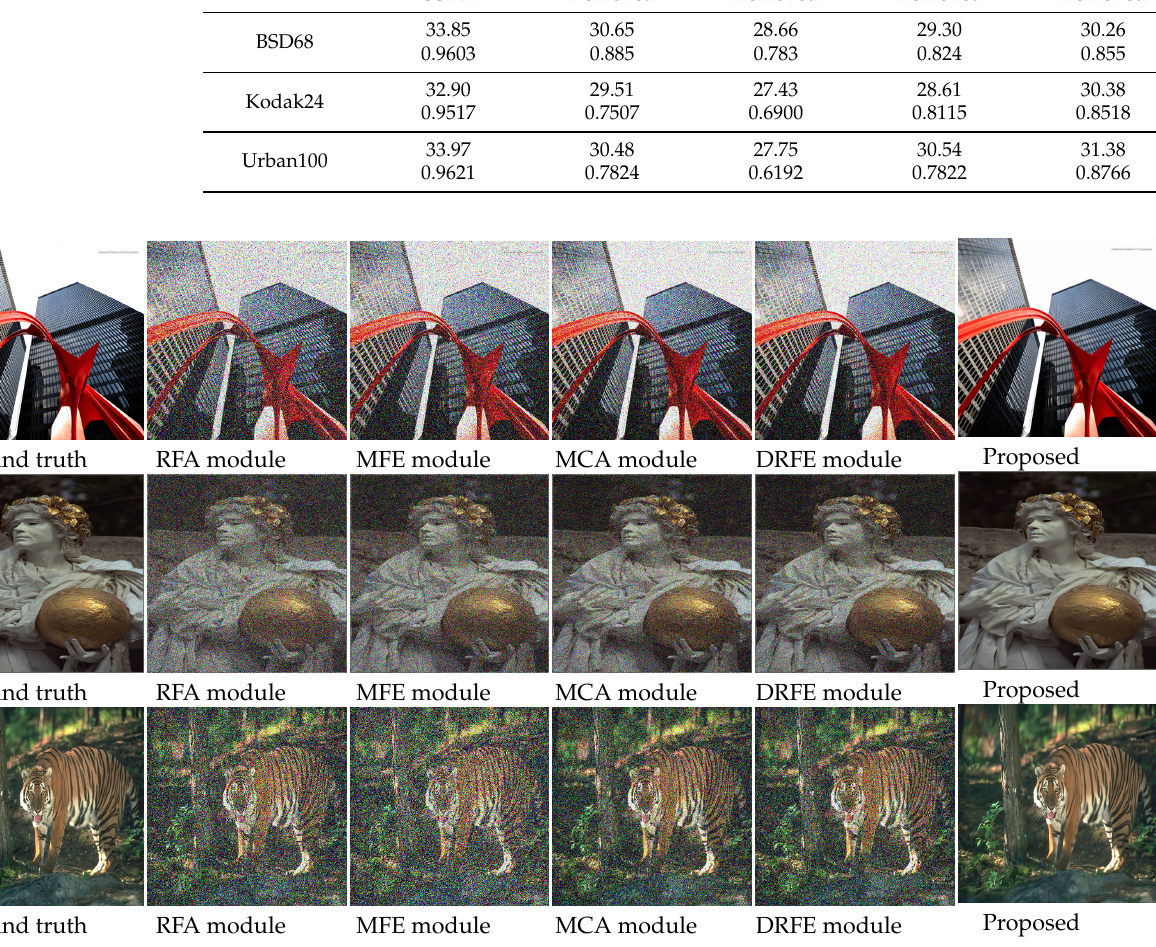
Figure 14. Sample results for all four modules separately (for best view, zooming in is